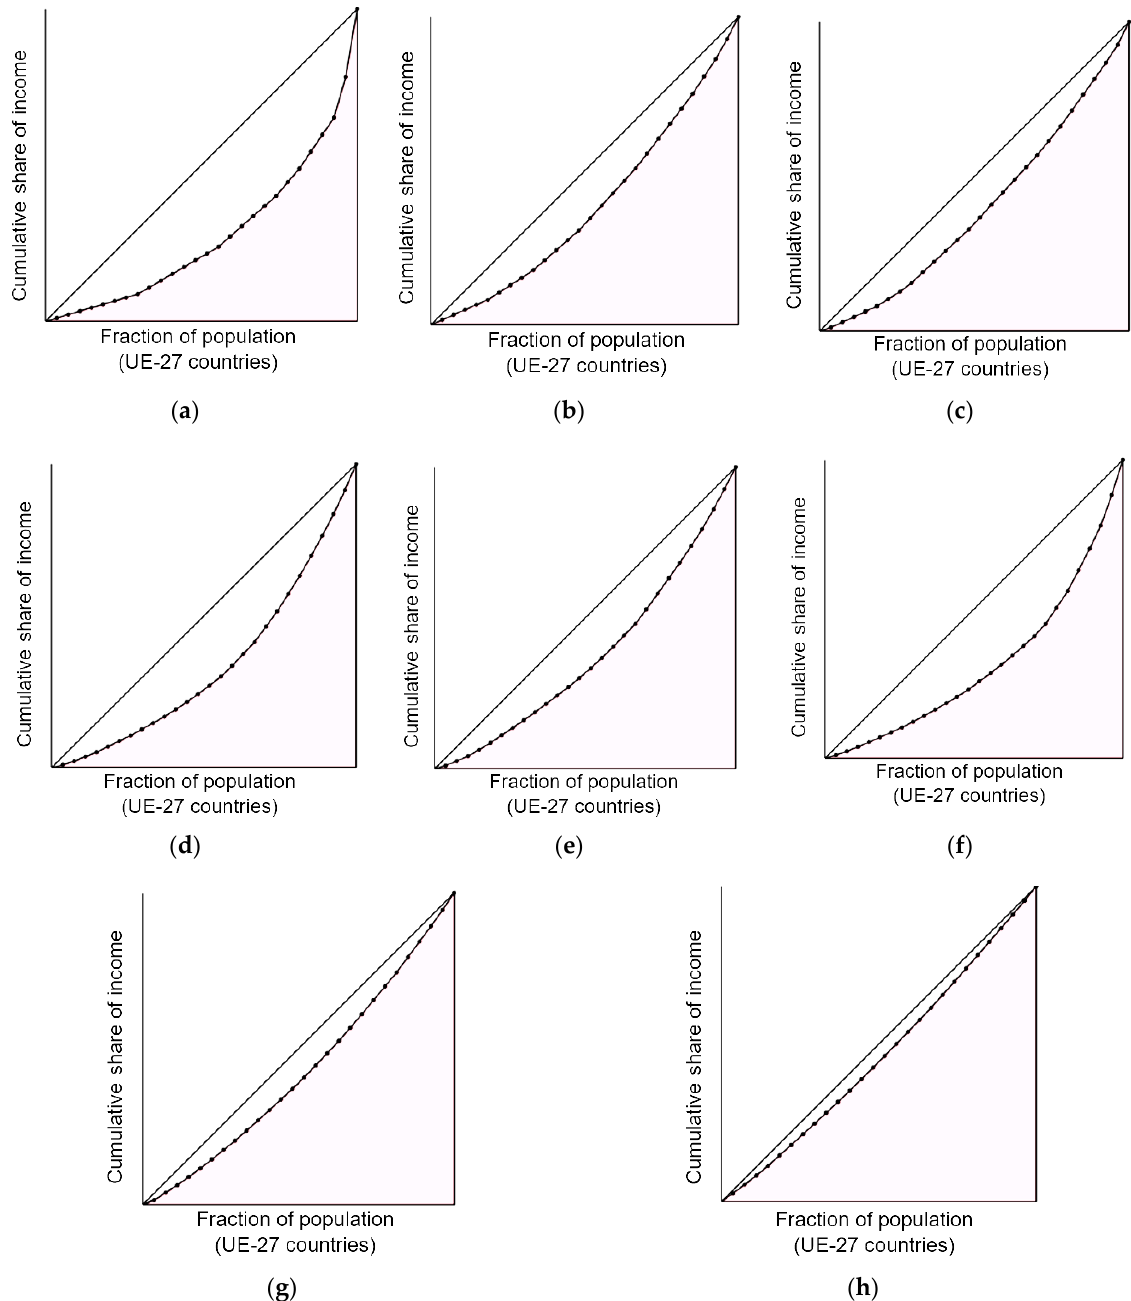
Figure 1. Lorenz concentration curves for Industry 4.0 technologies used in the EU enterprises for 2019 (( a ) — analysis of big data internally using machine learning, ( b ) — 3D printing, ( c ) — use of industrial or service robots, ( d ) — analysis of big data internally from any data source, ( e ) — cloud computing services, ( f ) — enterprises sending e-invoices, suitable for automated processing, ( g ) — ERP software package to share information between different functional areas, ( h ) — ICT security measure used: strong password authentication) (own elaboration).